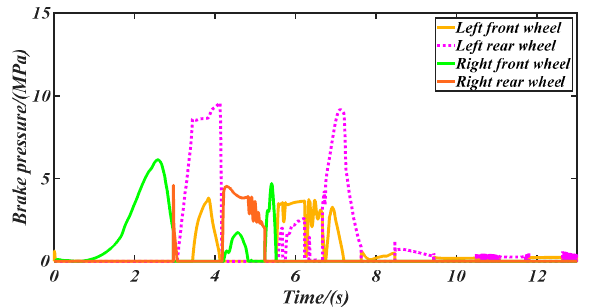
Figure 16. Brake pressure controlled by our proposed controller.